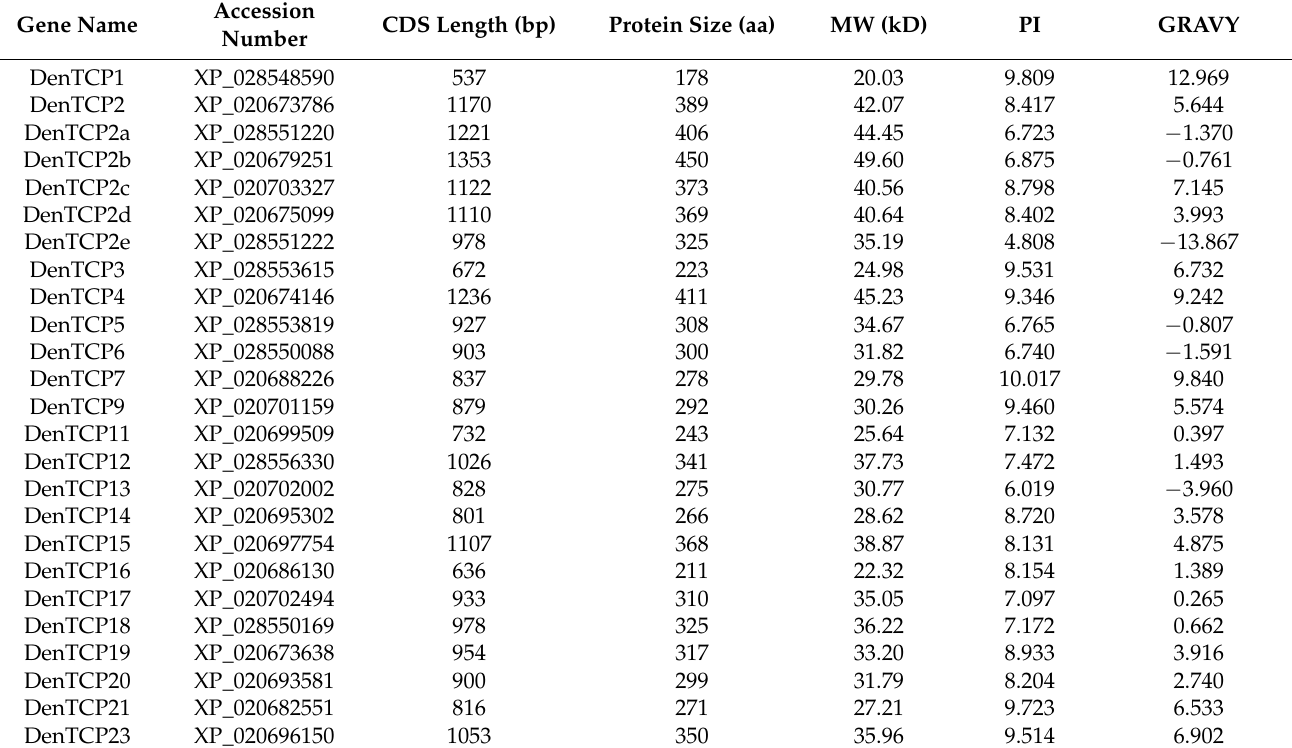
Table 1. Identification and characteristics of TCP genes in D. catenatum